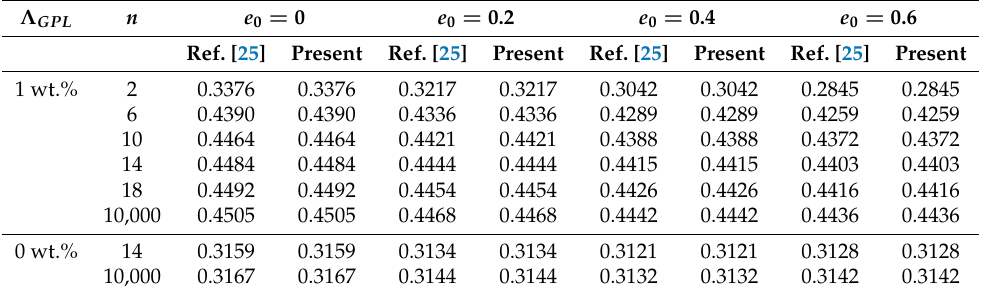
Table 1. The dimensionless fundamental frequency of C-C beams (porosity 1, GPL A, L / h = 20).